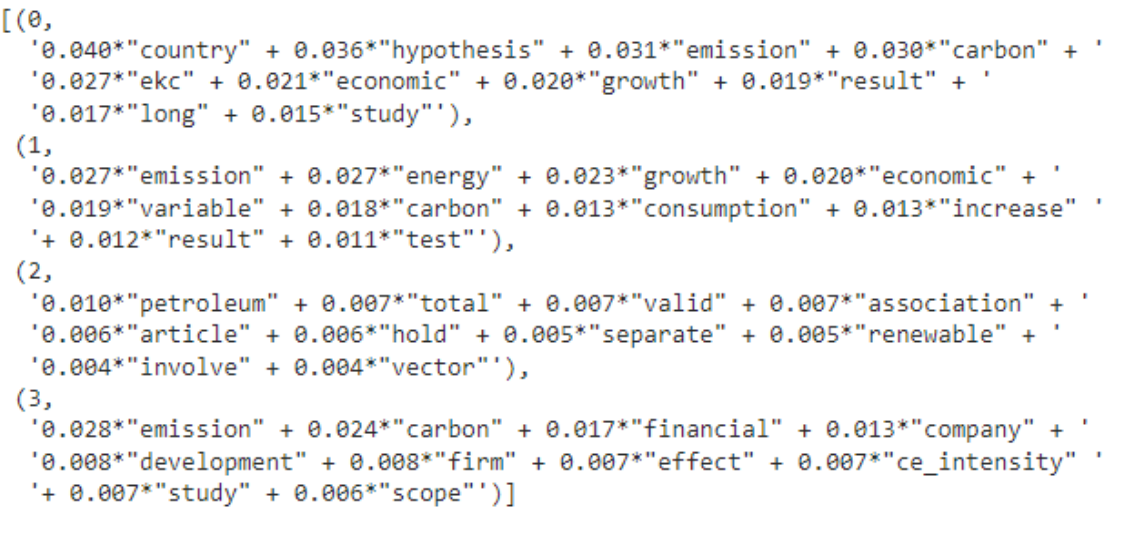
Figure 2. Topics and weights produced by Latent Dirichlet Allocation (LDA)